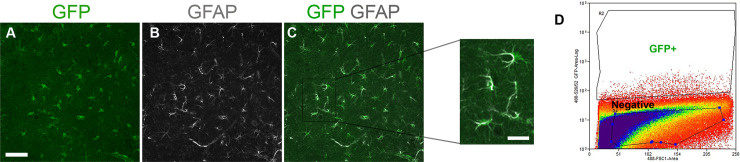
Fractionation of PAs from the cerebral cortices of adult Mlc1-EGFP mice.(A–C); Sagittal brain sections through the cerebral cortices of P30 mice were double immunolabeled with anti-GFP (A) and anti-GFAP (B) antibodies. Note the co-expression of GFP and GFAP in astrocytes (C). Scale bars, 50 μm (A) and 10 μm (inset, C). (D); Flow cytometric analyses of dissociated cerebral cortical cells from Mlc1-EGFP mice reveals that a low percentage of cells express EGFP (EGFP+). Note that the vast majority of cells do not express EGFP (Negative).